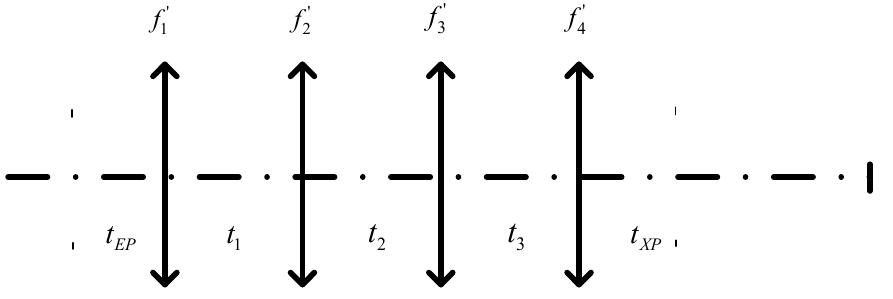
Figure 2. Schematics of the zoom lens design model.